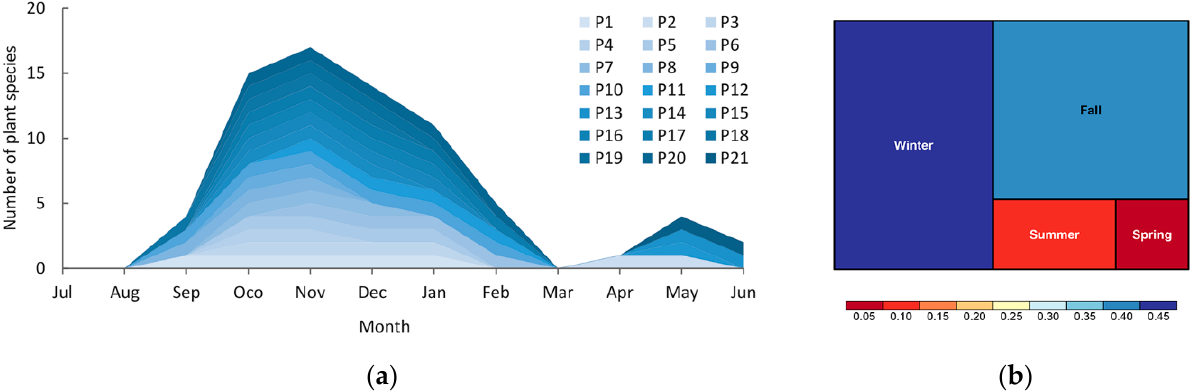
Figure 2. Fruit ripening phenology: ( a ) fruit ripening phenology of 21 species of fruit plants; ( b ) the connections of different seasons contribution to the total plant – frugivore network, the color bars with the gradient of red to blue below the main figure indicate the proportion of interaction connections to the total network in different seasons.